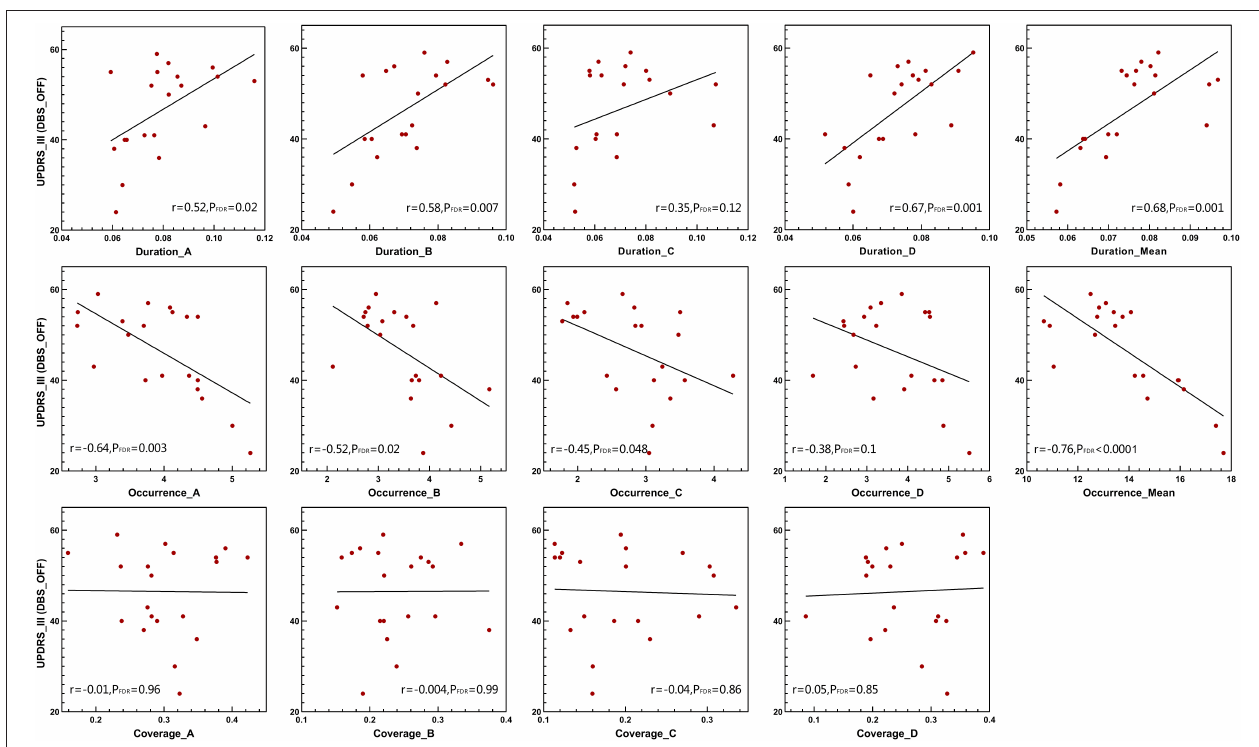
FIGURE 4 | Clinical UPDRS-III correlations. Pearson’s correlations between microstate parameters and UPDRS-III scales in DBS-OFF state. DBS, deep brain stimulation; UPDRS-III, the Unified Parkinson’s Disease Rating Scale III.